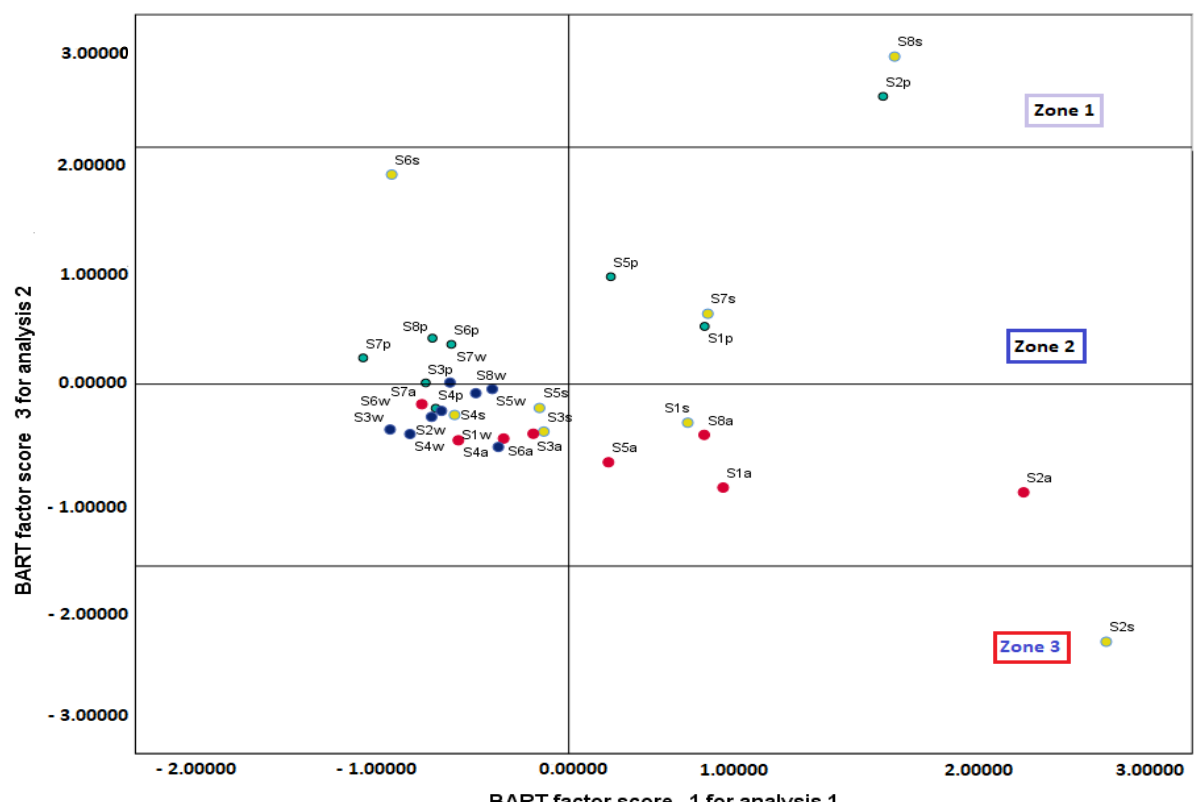
Figure 5. Station scores using axis 1 and axis 3.